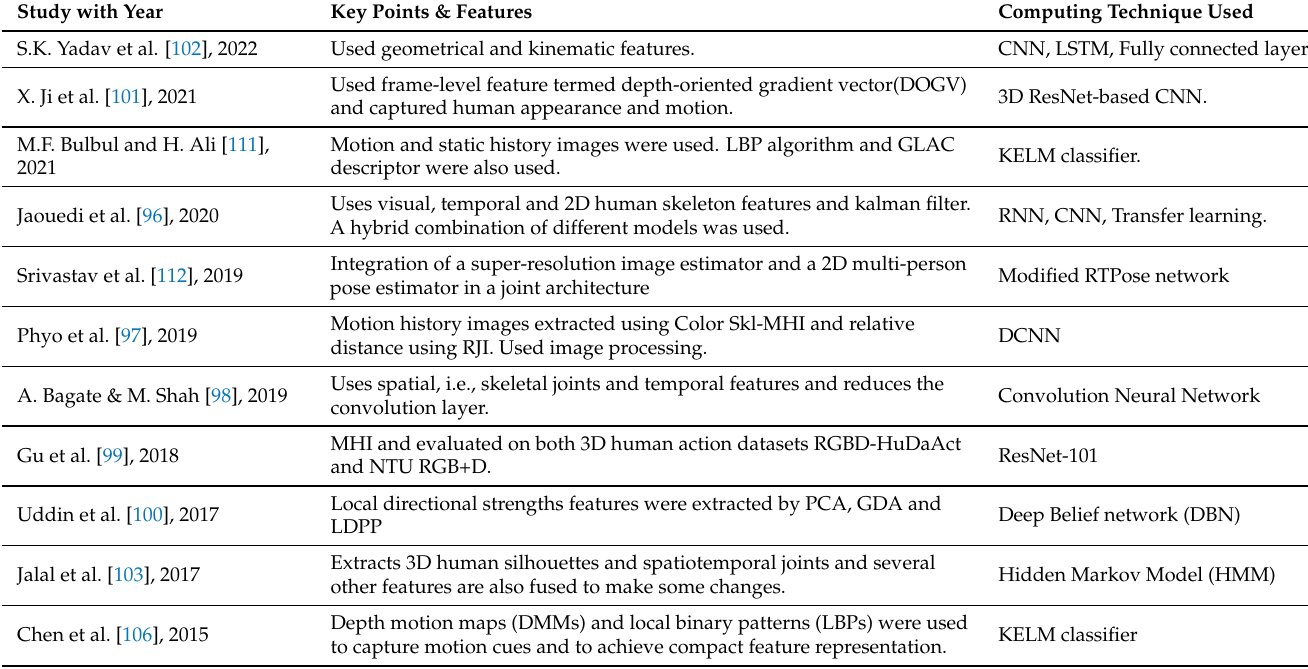
Table 3. Overview of the activity analysis using depth image classification without the gait parameter from the last